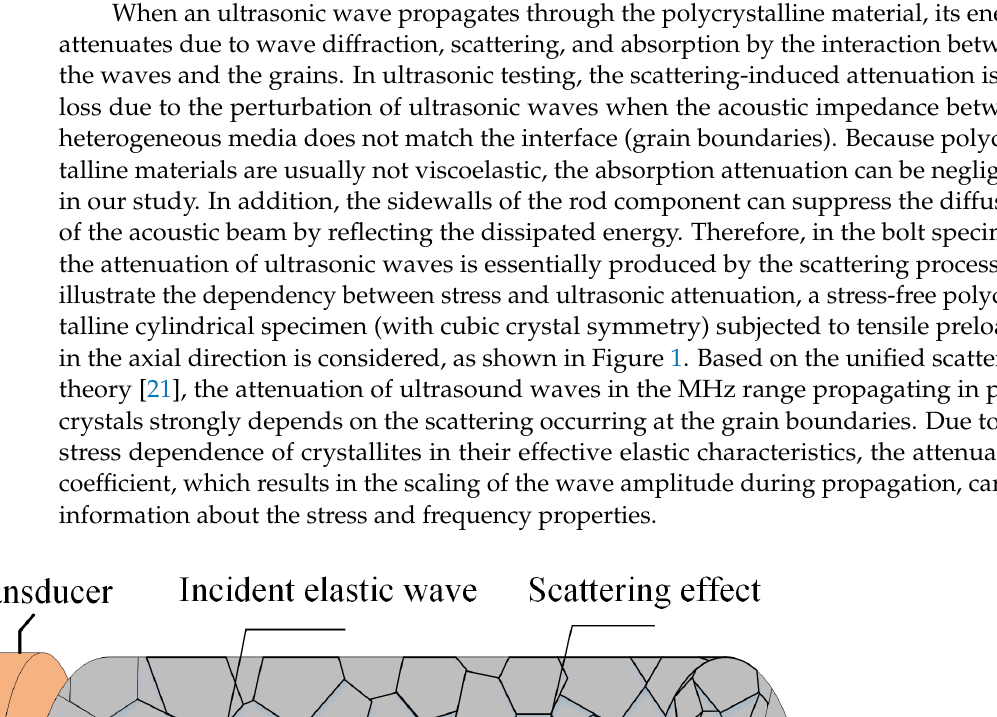
Figure 1. Ultrasonic wave propagation in bolt under the axial stress.